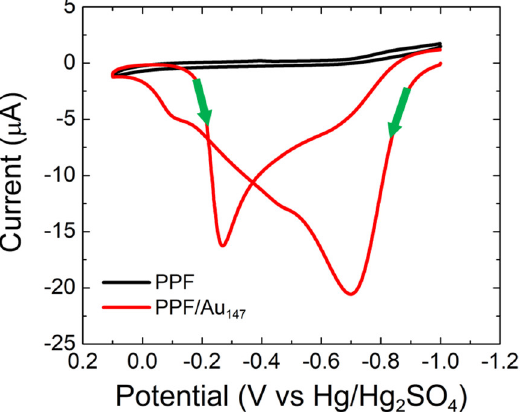
Figure 1. CVs obtained for CO electrooxidation on bare PPF and PPF/Au 147 electrodes. The solutions contained aqueous, CO-saturated 0.10 M NaOH. The electrode potential was scanned between −1.0 and 0.10 V at 0.050 V/s. The experiments were carried out in triplicate for each electrode configuration using independently prepared electrodes to ensure reproducibility.